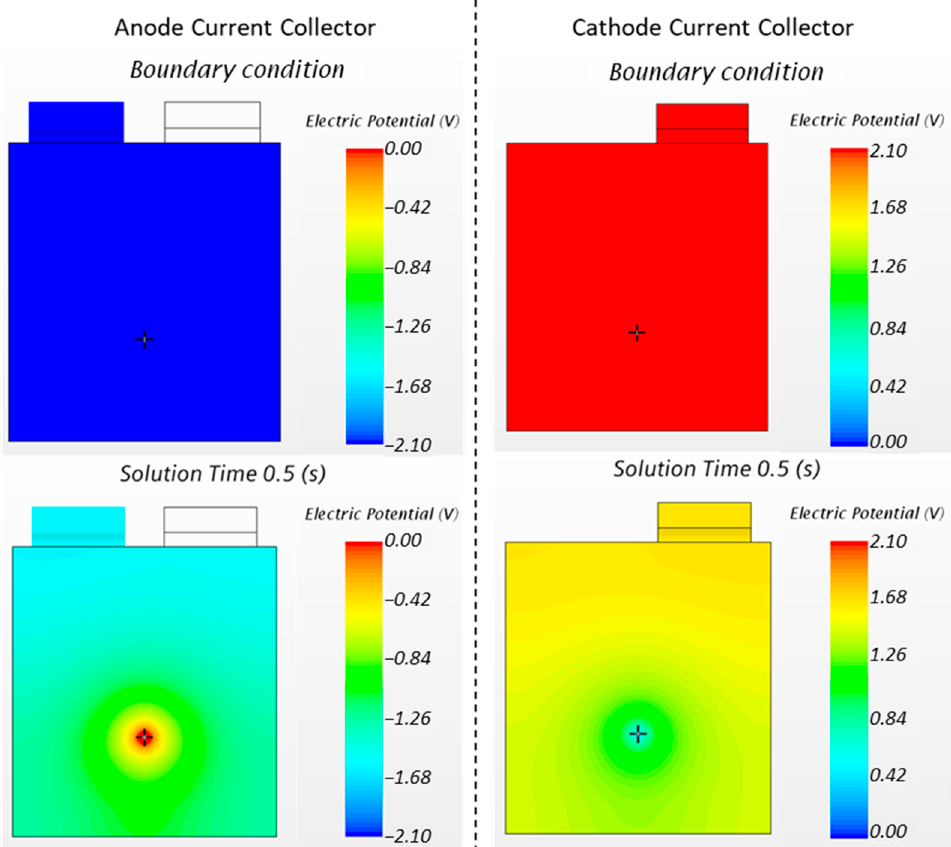
Figure 10. Voltage distribution on the anode and cathode current collectors for the nail penetration load case at different stages. The boundary condition of 100% SOC sets the differential voltage to 4.2 V (+2.1 V for the cathode and − 2.1 V for the anode). During the transient period, the local differential voltage around the nail is markedly lower than the voltage measured at the tabs.